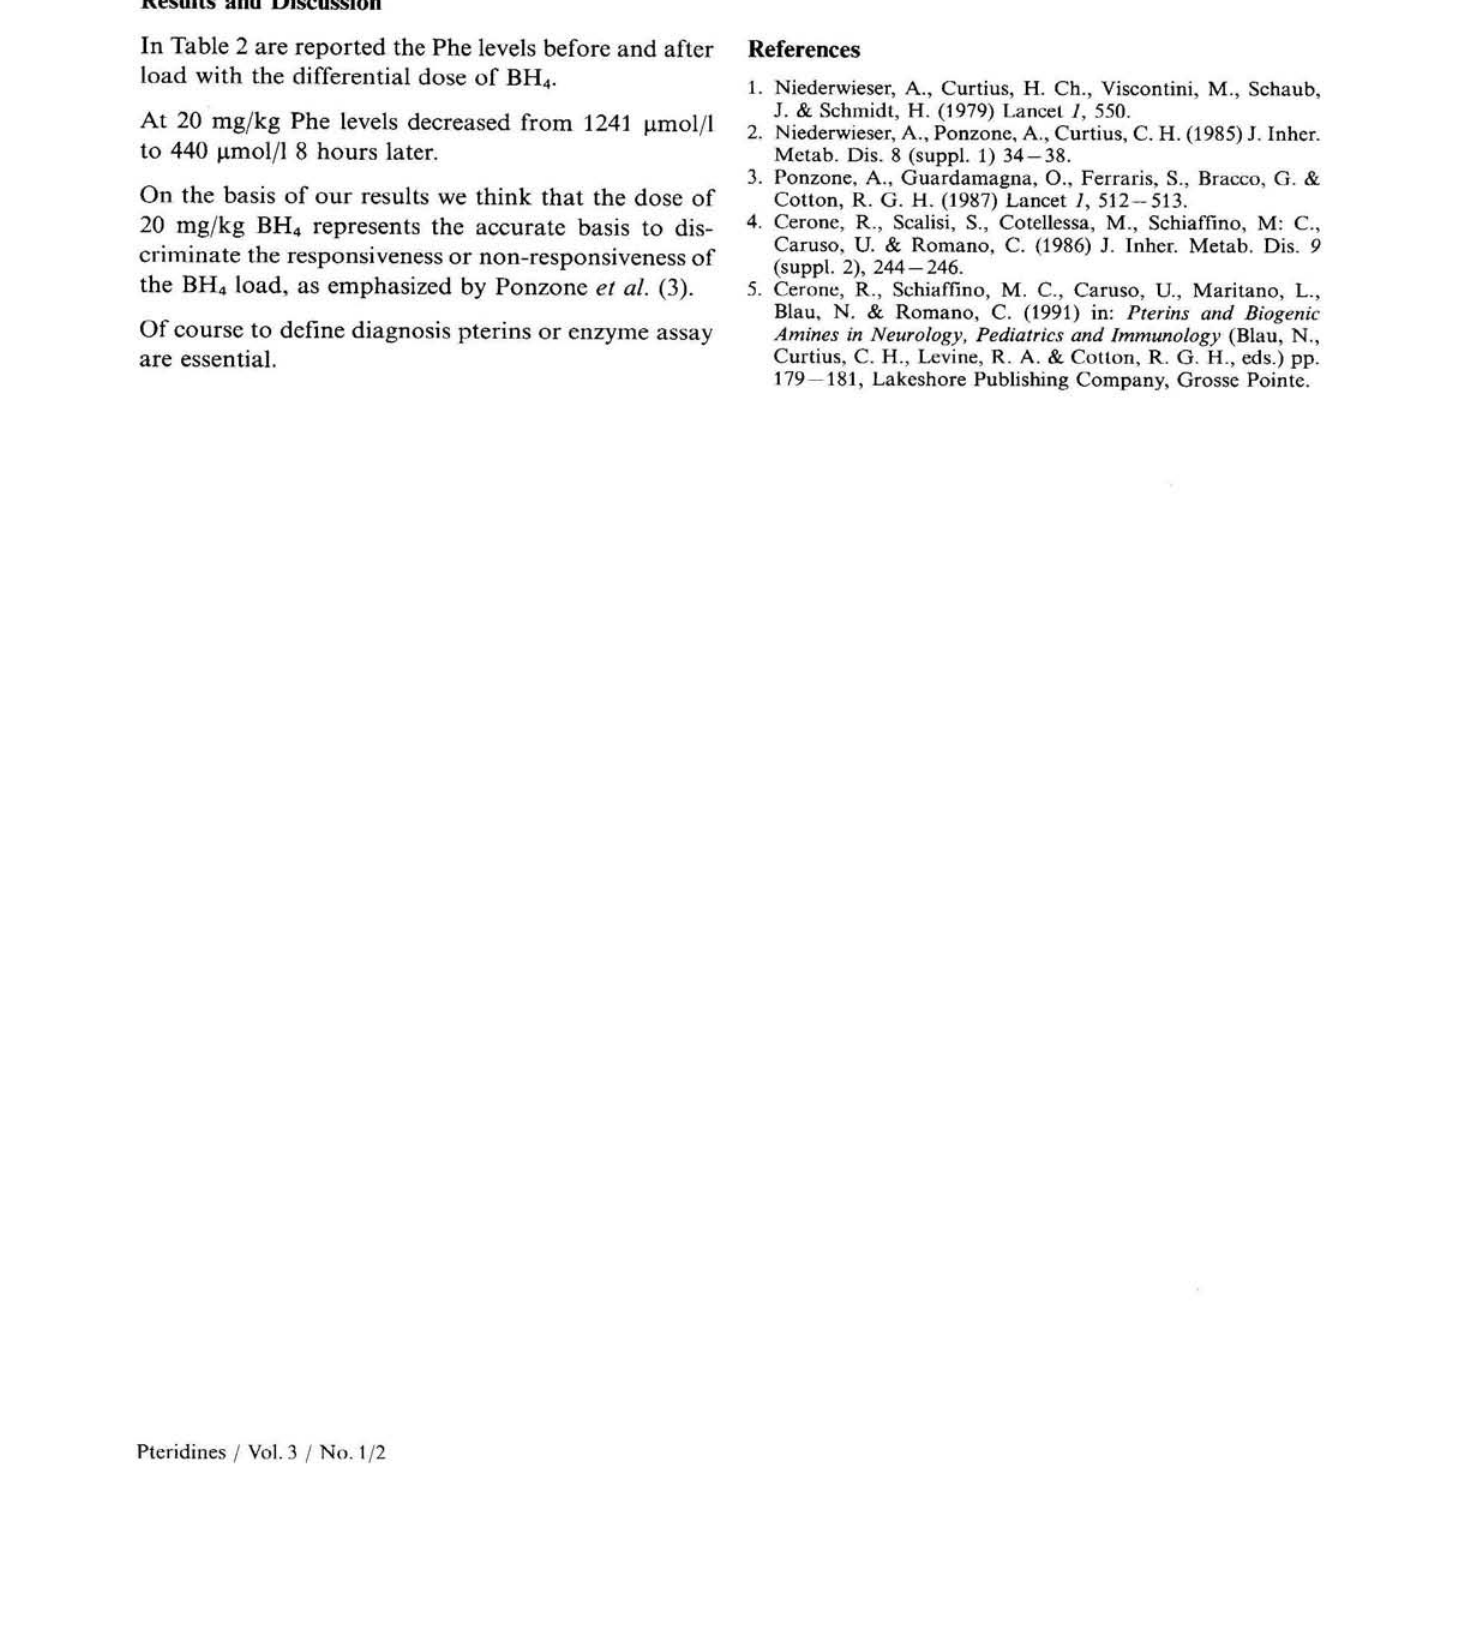
Table 2. Phenylalanine levels after loading with different doses of BH